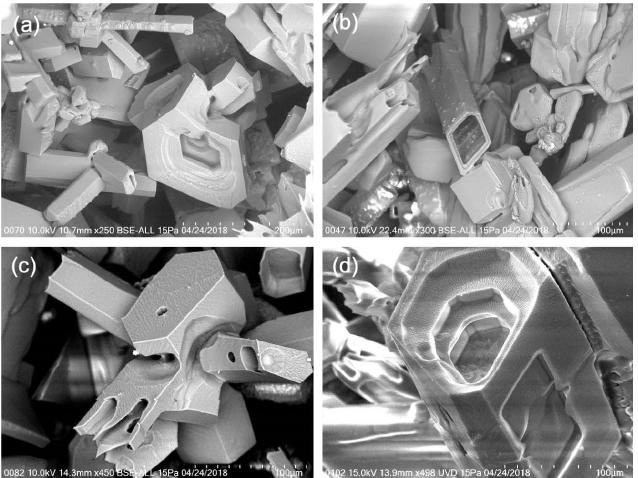
Figure 1. Complex ice crystal particles with a modest magnification of 250–4500 times. ( a ) bul- let rosette and unclassified compact convolution ’singular polyhedron’; ( b ) rhomboid and pris- matic linear coarser crystals with discrete adhesion spots on the surface; ( c ) rosette mixed crys- tals; ( d ) irregular cross section of the base, geometrically stratified and hollow columnar, a highly coarser crystal [10].